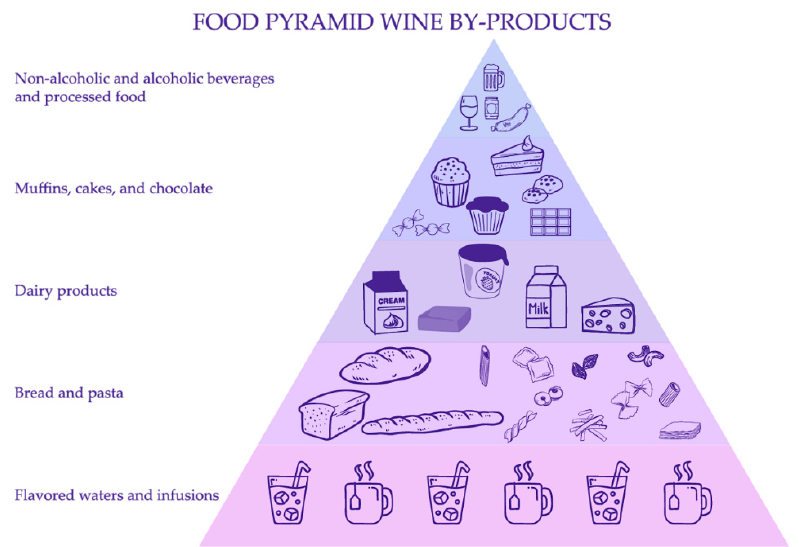
Figure 2. Valuable applications of wine by-products in the food pyramid of the Mediterranean Diet.